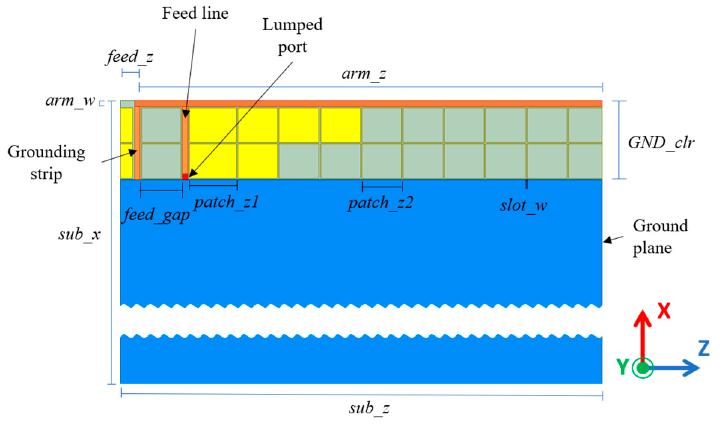
Figure 3. Design parameters of the inverted-F antenna (IFA) antenna with parasitic patches. The IFA element is in orange and FR4 substrate is in blue.